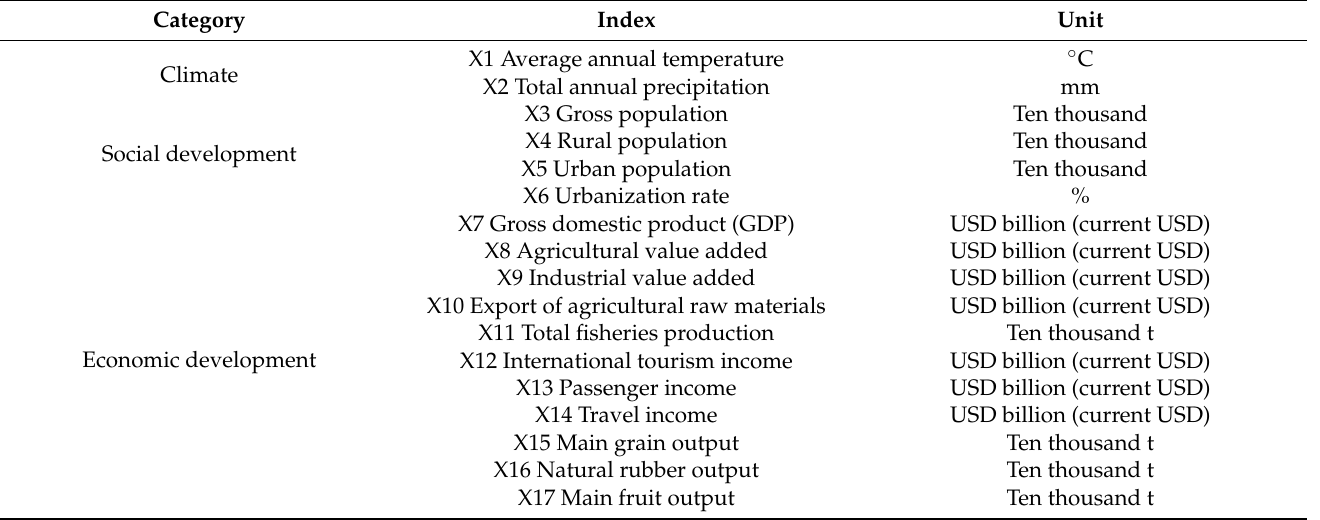
Table 3. Indicators and their categories of economic and social development statistics from 2000 to